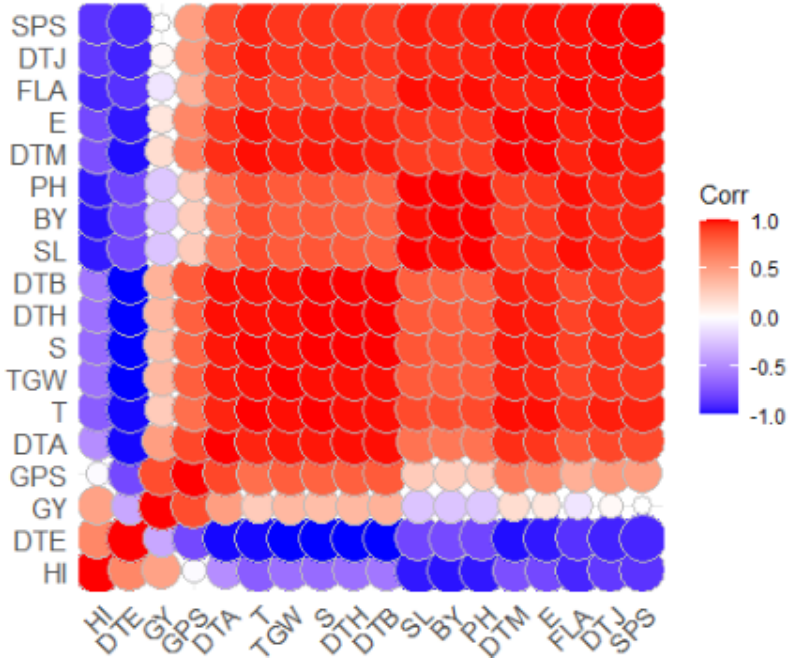
Figure 1. Correlation plot for the studied traits of different wheat genotypes as influenced by sowing dates. HI = harvest index, DTE = days to emergence, GY = grain yield, GPS = grains per spike, DTA = days to anthesis, T = tillers m − 2 , TGW = thousand grain weight, S = spike m − 2 , DTH = days to heading, DTB = days to booting, SL = spike length, BY = biological yield, PH = plant height, DTM = days to physiological maturity, E = days to emergence, FLA = flag leaf area, DTJ = days to jointing, SPS = spikelets per spike.